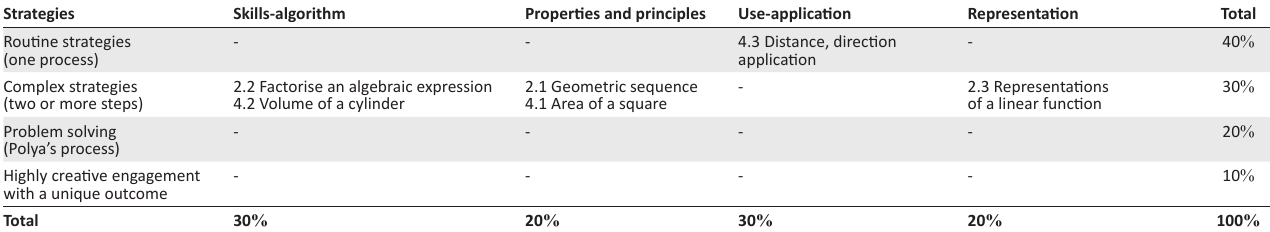
TABLE 4: Dimensions of understanding, levels of processing, and possible weightings.